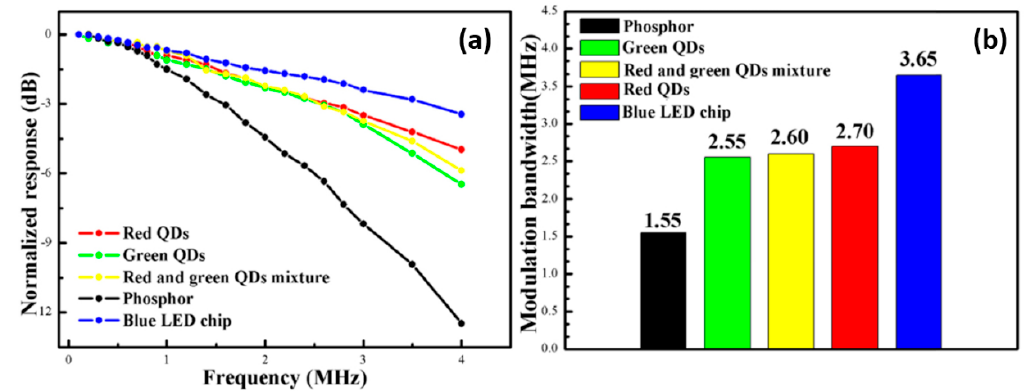
Figure 15. Comparisons of ( a ) frequency responses and ( b ) modulation bandwidths for different LEDs with phosphor, red, green, a mixture QDs and without phosphor or QDs. [92] Figures reproduced with permission from Optical Society of America.